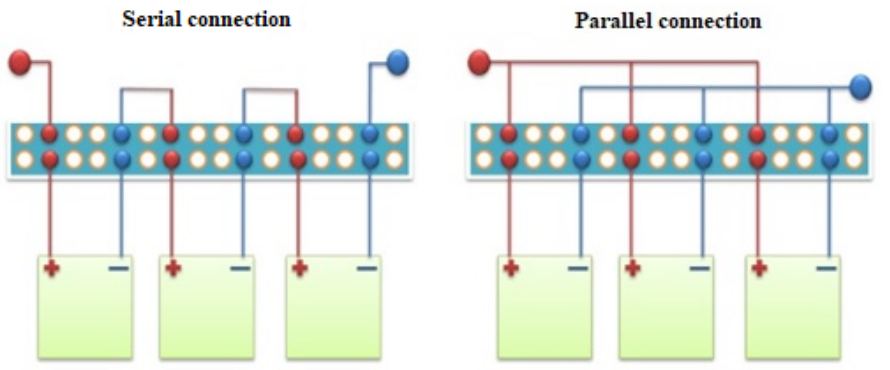
Figure 12. Serial and parallel connections of the thermoelectric modules in the thermoelectric converter switching unit of the gas cooling module.